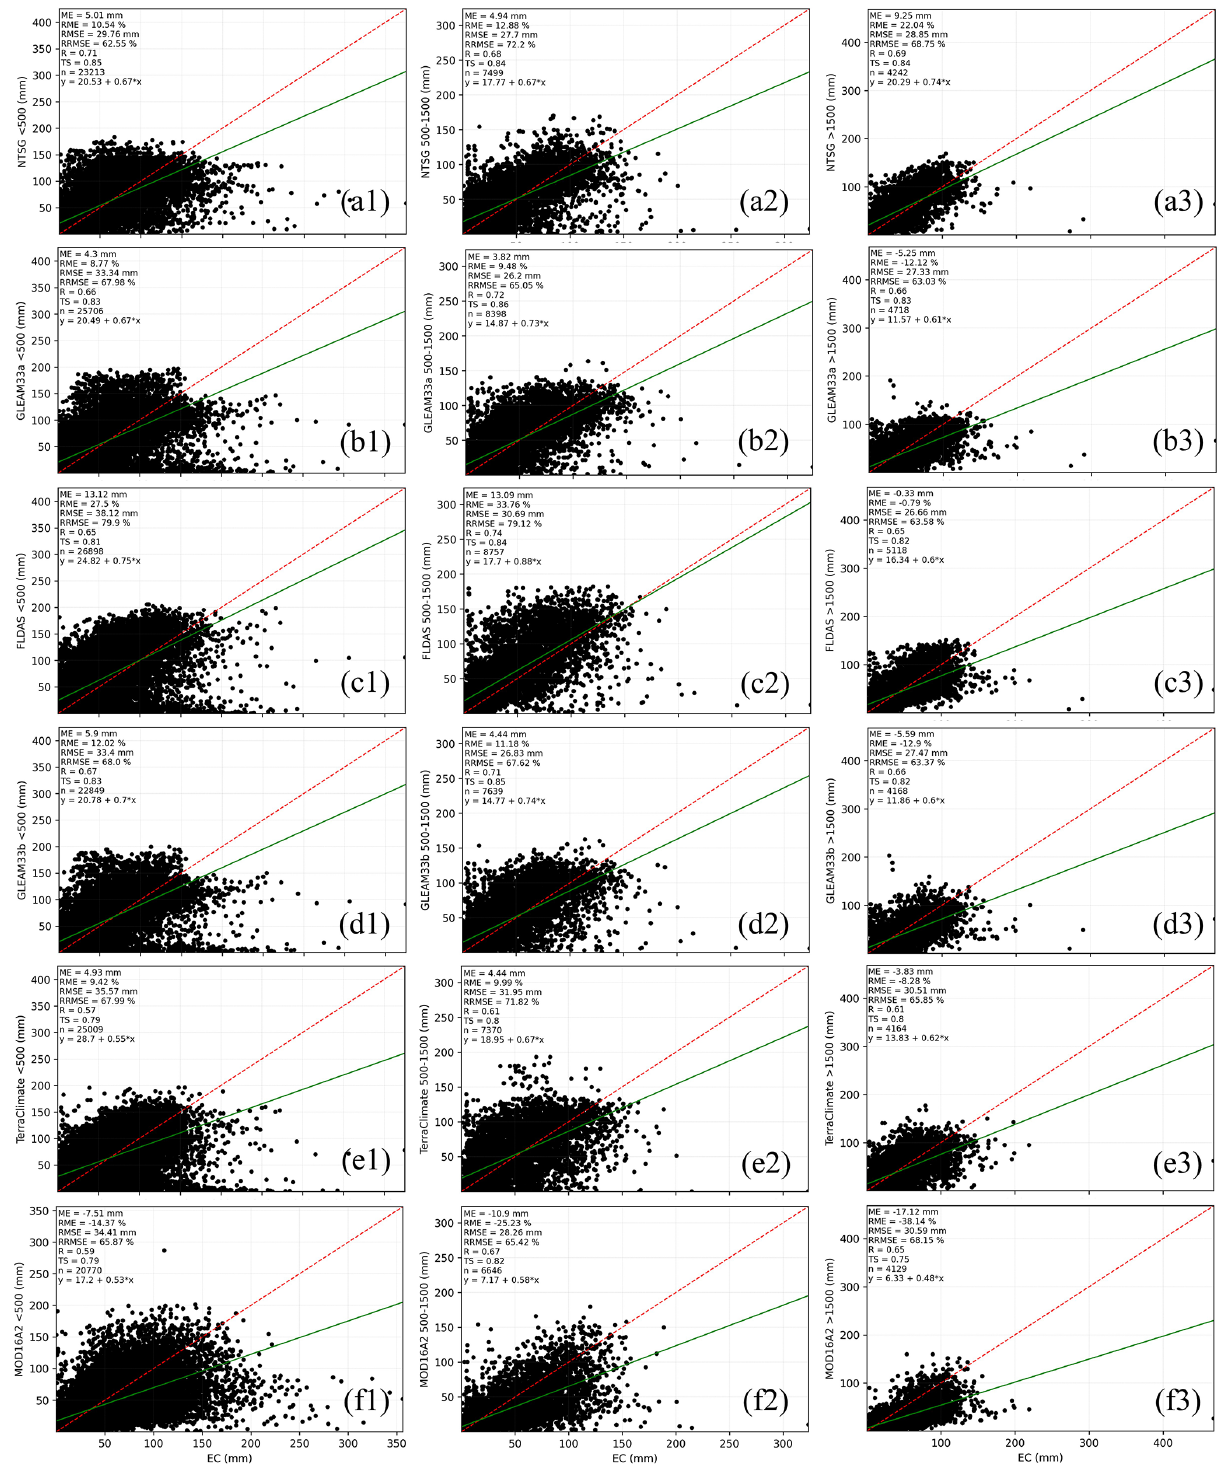
Figure 12. Monthly ET products (NTSG: a ; GLEAM33a: b ; FLDAS: c ; GLEAM33b: d ; TerraClimate: e ; MOD16A2: f ) against flux EC ET aggregated for all sites for each elevation level ( < 500m: 1; 500–1500m: 2; > 1500m: 3).